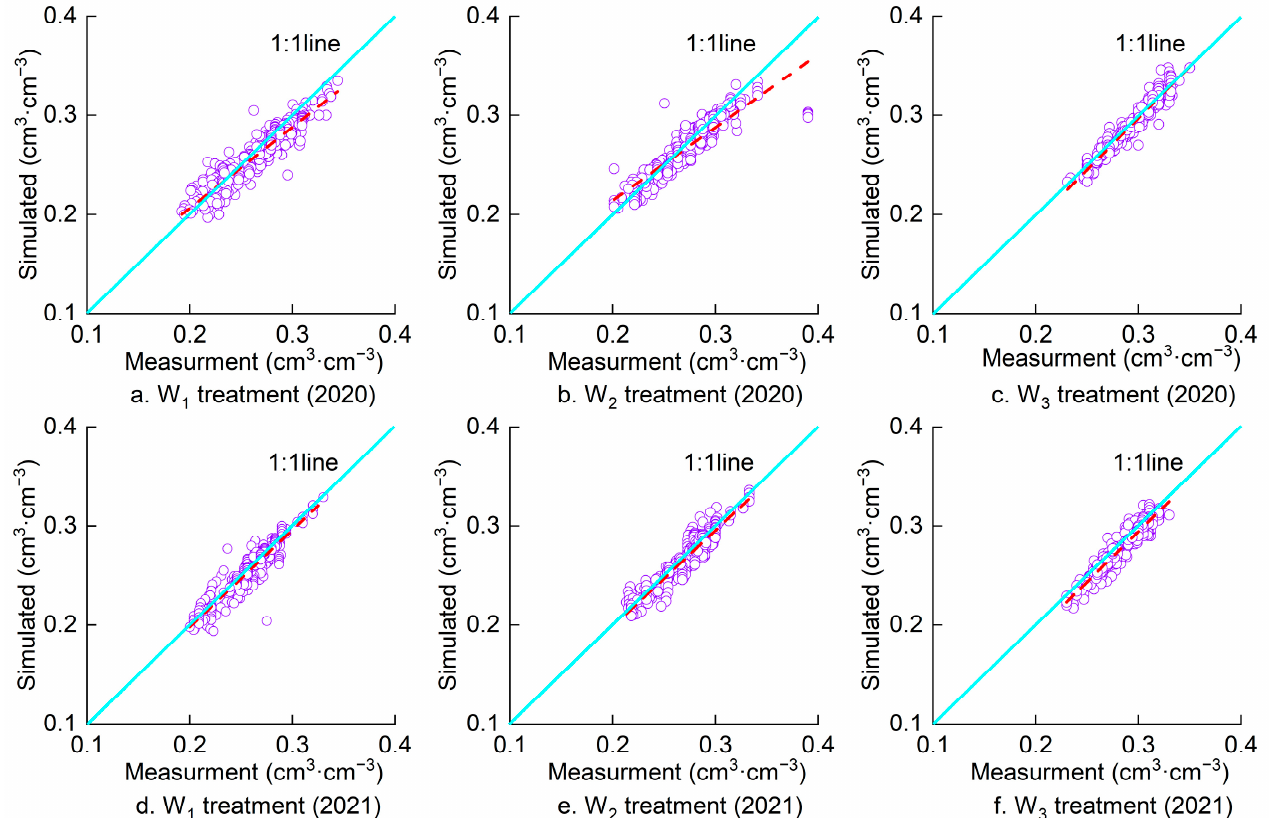
Figure 3. Coefficient of determination (R 2 ) between simulated and measured soil water content (cm 3 ·cm − 3 ) under different water treatments, in 2020 and 2021. Table 2. Soil hydraulic parameters of different soil Table 1. Statistical indicators to evaluate the accuracy of the HYDRUS-2D model in the estimation of soil water content (cm 3 ·cm − 3 ) under different water treatments.